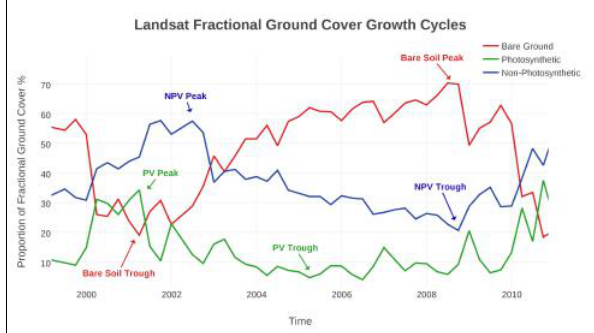
Figure 1. Landsat Fractional Ground Cover time-series plot of a one hectare area of arid rangeland. Major change points indicate ground cover growth cycles. The NPV growth cycle is notably larger than the PV.